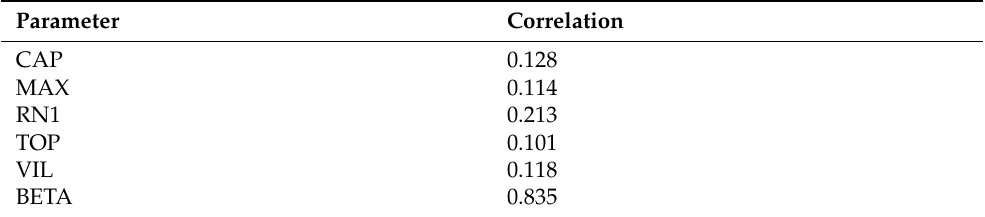
Table 2. Correlation coefficient and beta parameter for the different radar variables in front of CG density for the case of 22 October